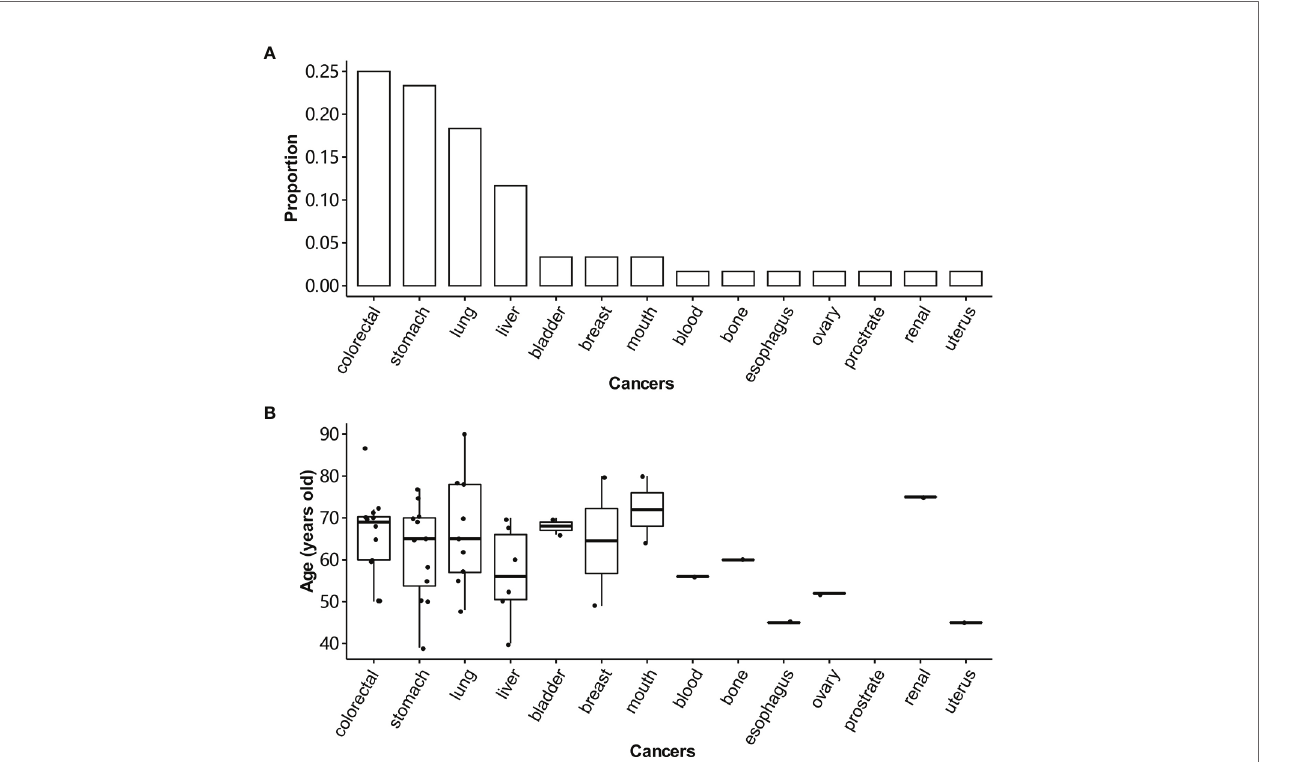
FIGURE 1 | Distribution of cancers in the family members of CRC patients. (A) The cancer frequency distribution of family members for CRC patients. Patients with a family history are the ones whose parents, siblings, or children have cancer. (B) The age distribution of family members over tissue for CRC